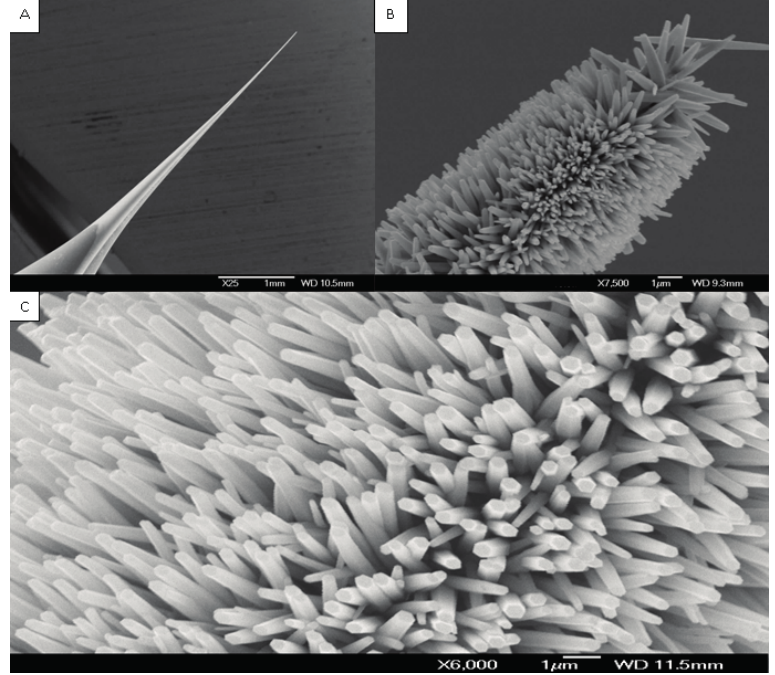
Figure 1. Field emission scanning electron microscope images at different